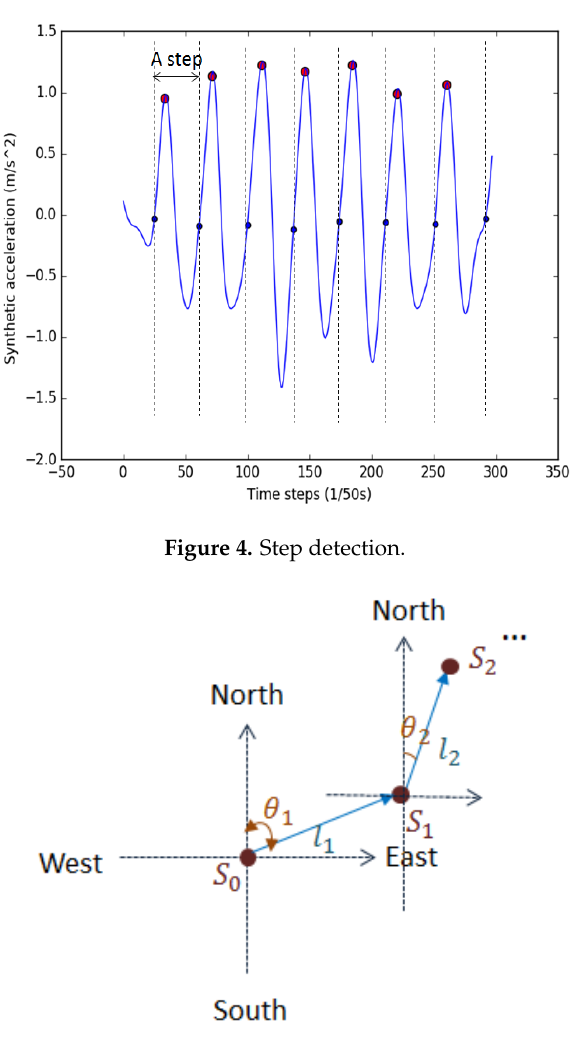
Figure 5. Location estimation.